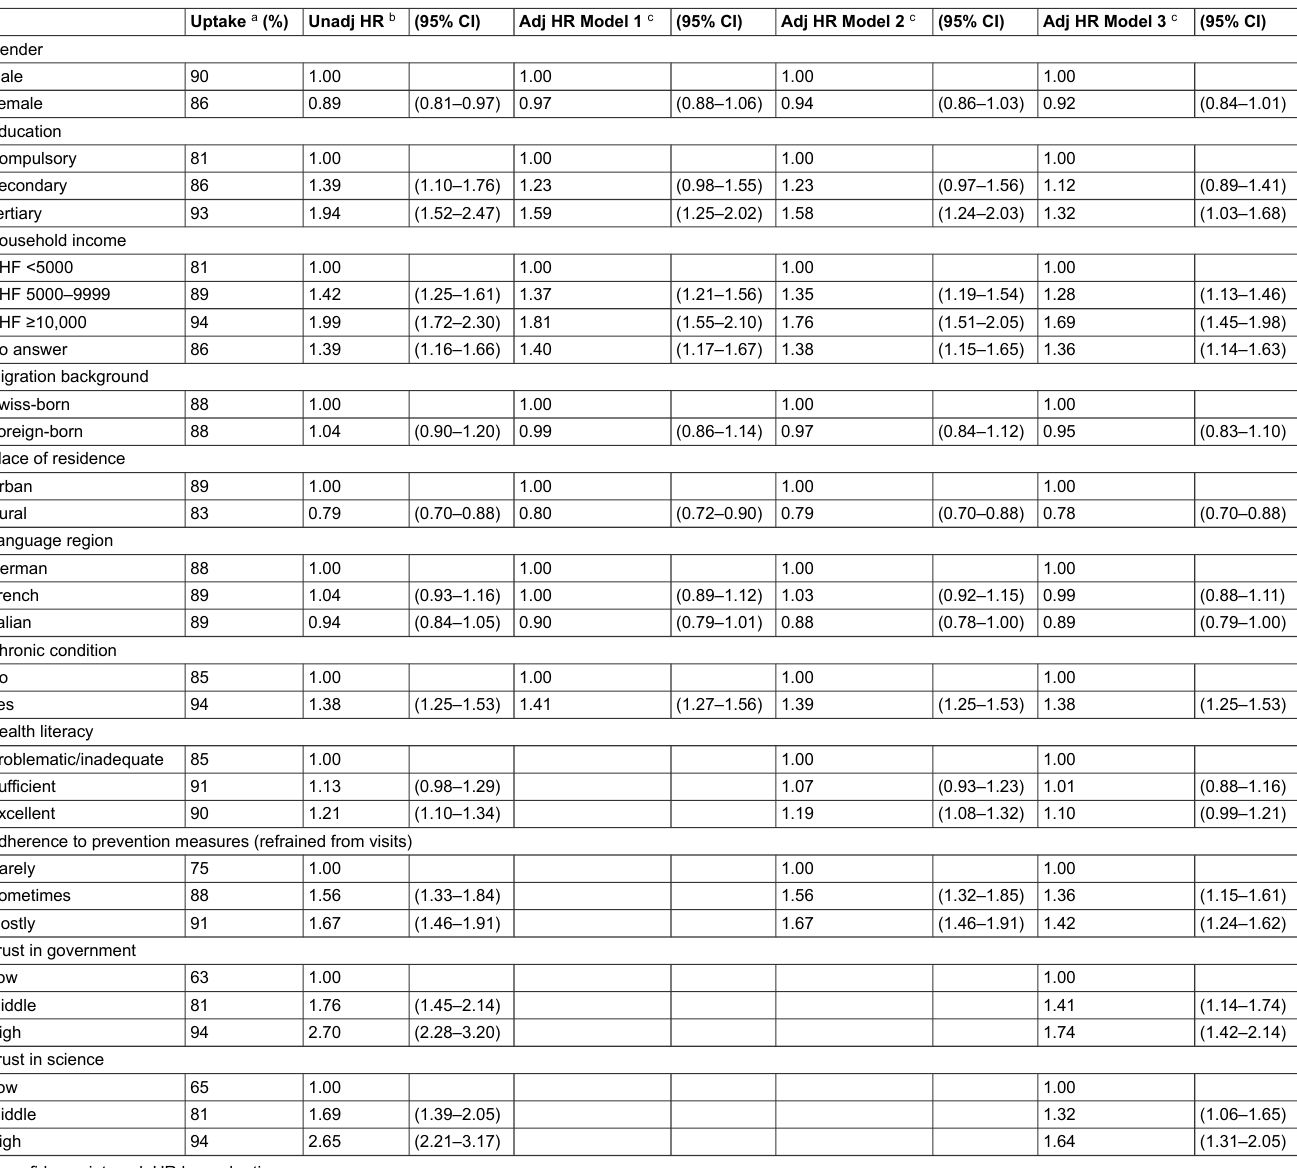
Table 4: COVID-19 vaccine uptake and Cox proportional hazard ratios from univariable and multivariable analyses (N=2,448). Uptake a (%) Unadj HR b (95%